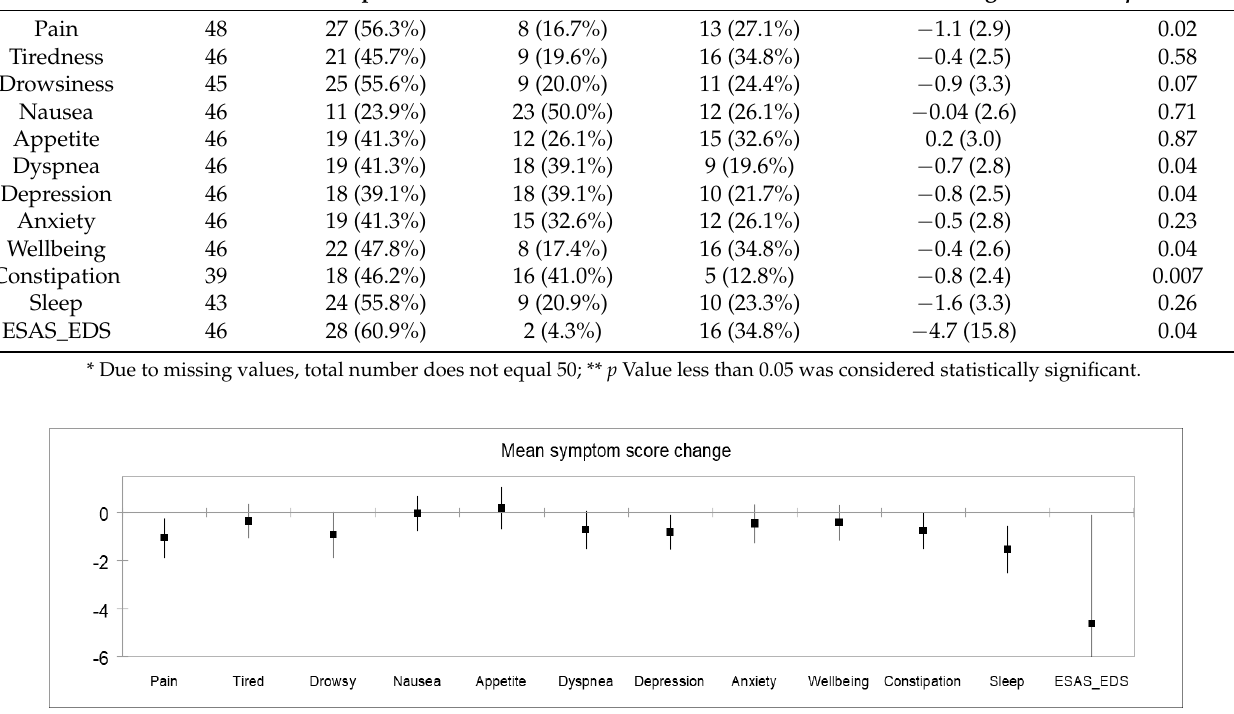
Table 3. Change in symptom severity between the initial IAPCPC consultation and the first follow-up.